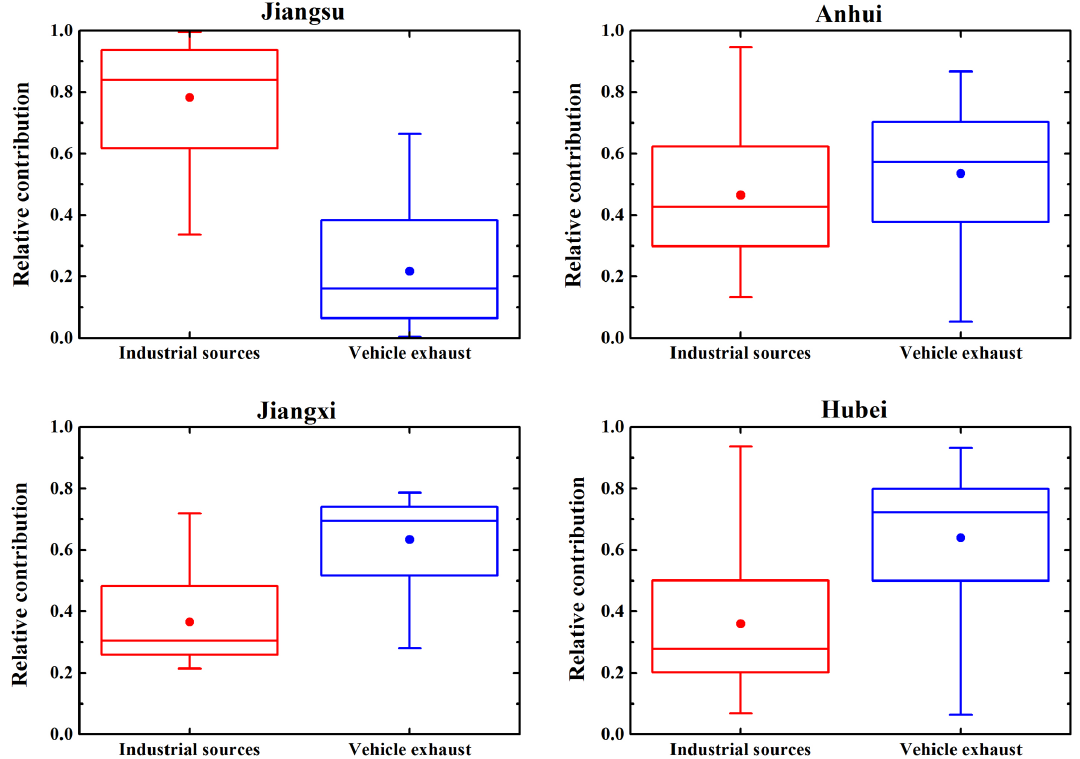
Figure 11. Relative contributions of industrial sources and vehicle exhaust to the ambient NO 2 levels over the four provinces. Note that the bottom and top of the box represent the 25th and 75th percentiles, respectively; the line within the box represents the median; the dot represents the mean; the whiskers below and above the box stand for the 10th and 90th percentiles.